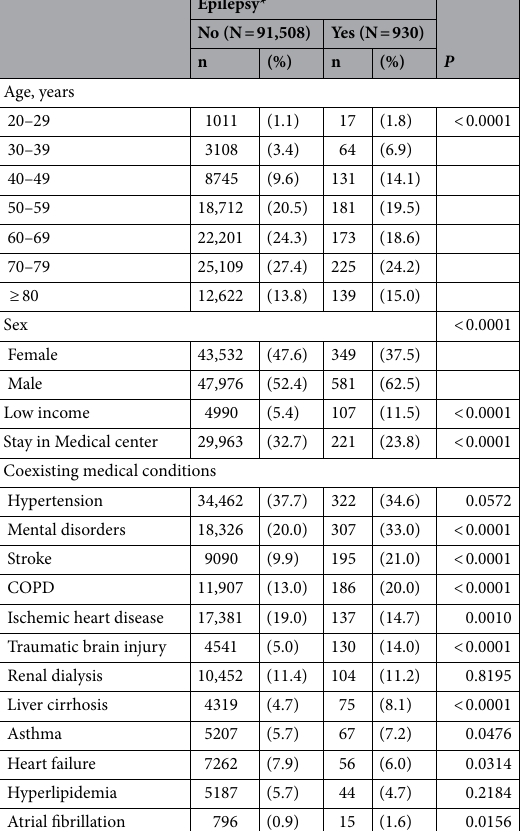
Table 3. Characteristics of hospitalized diabetes patients with and without previous epilepsy. COPD chronic obstructive pulmonary disease. *New-diagnosed diabetes after